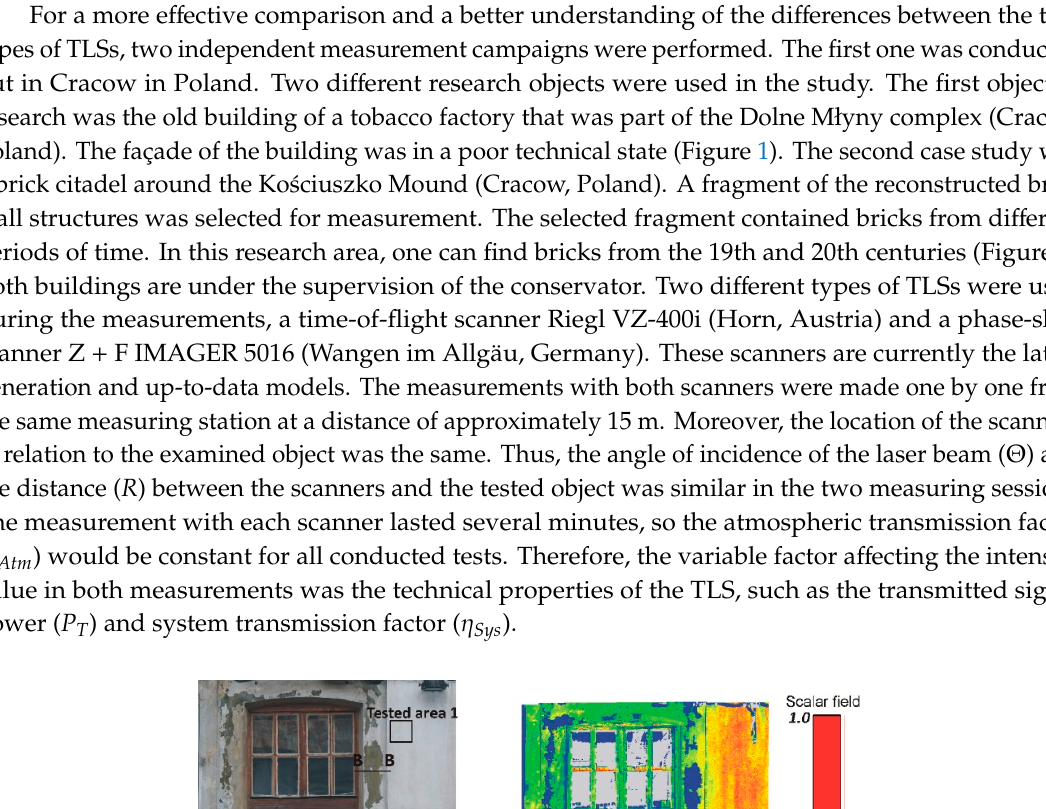
Figure 2. Part of the citadel brick wall—real photo on the left, point cloud on the right.